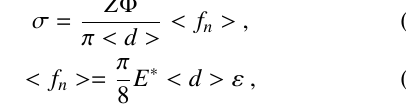
Figure 2. The excess vertical stress  the e ↵ ective modulus E ⇤ as a function of the vertical strain " for an elastic grain packing.  c correspond to the jamming point; here,  c 0 . 8. The lines show the predicted behavior around the ' jamming state; see Eq.